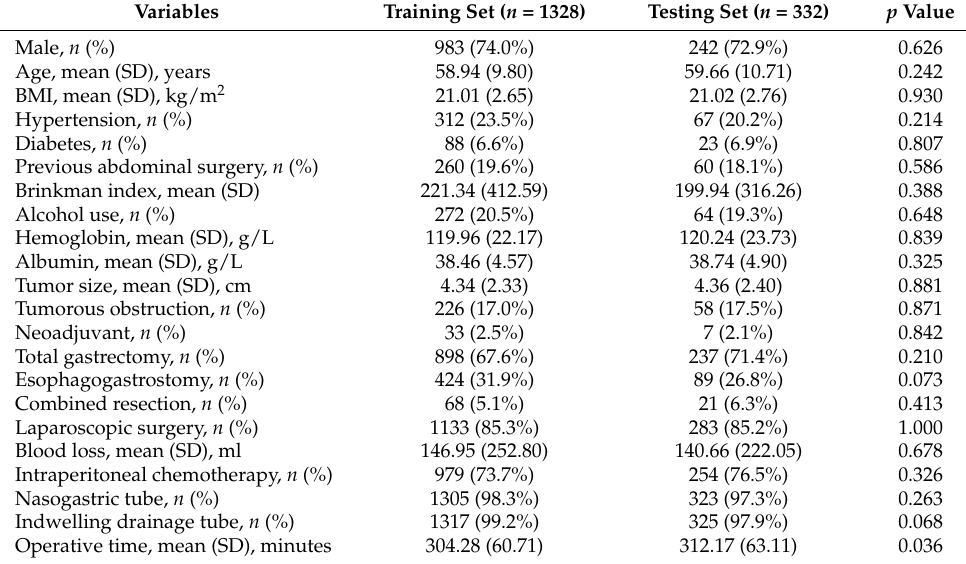
Table 1. Comparison of the training and testing